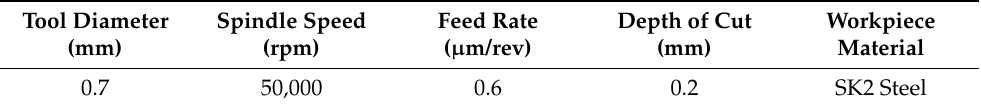
Table 3. Cutting parameters.